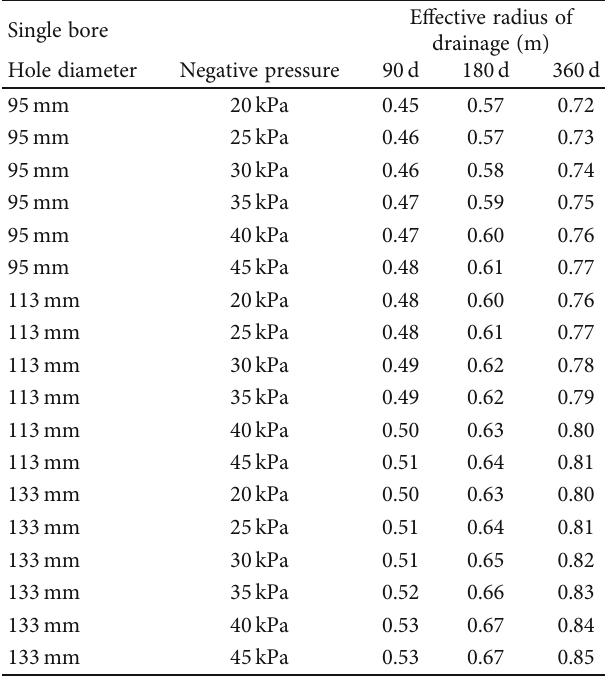
E ff ective radius of drainage